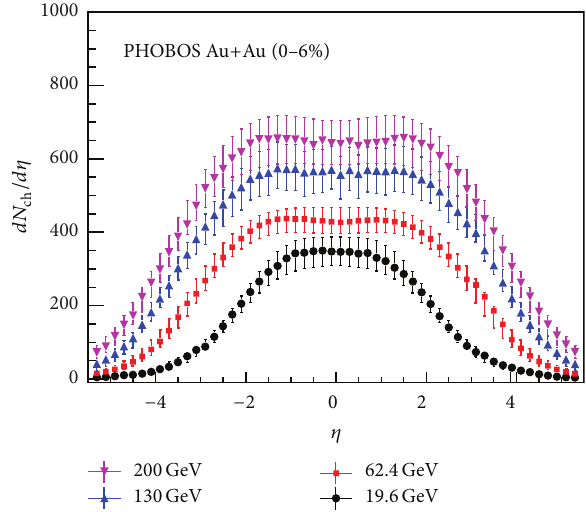
Figure 3: Charged particle pseudorapidity distributions of Au+Au collision system for the most central events for different collision